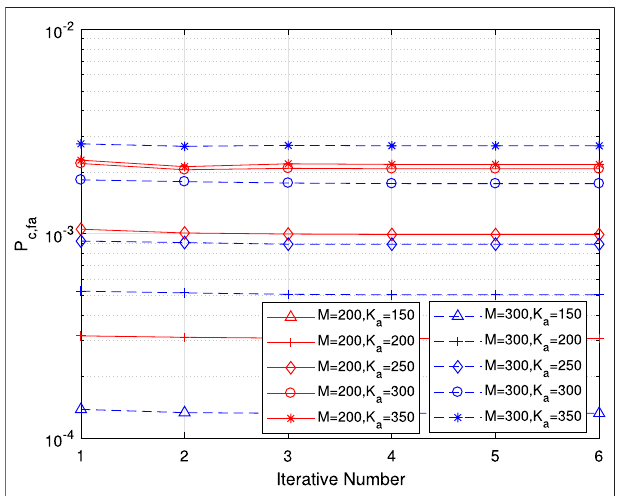
FIGURE 12 | Per-user error probability of false alarm for common information as a function of the iterative number for various numbers of antennas and active